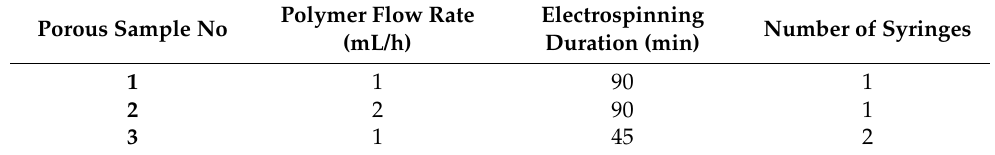
Table 1. Electrospinning process parameters used in the fabrication of in-house membranes and